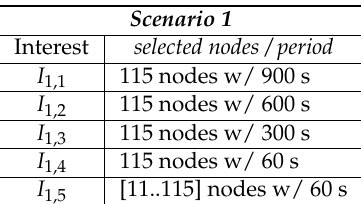
Figure 1. Scenario 1 node map (sink is X). Table 1. Scenario 1 evaluation Interest messages.